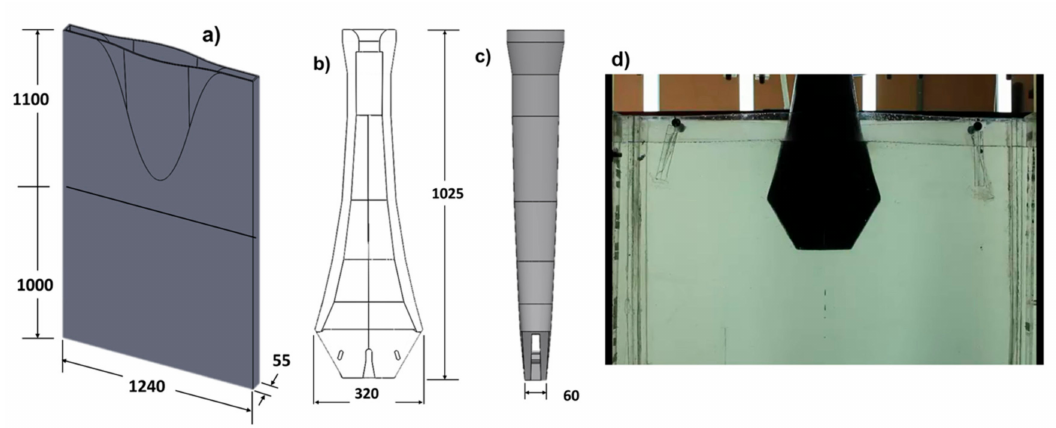
Figure 1. Dimensions in mm, ( a ) mold, ( b ) frontal view of the SEN, ( c ) lateral view of the SEN and ( d ) physical